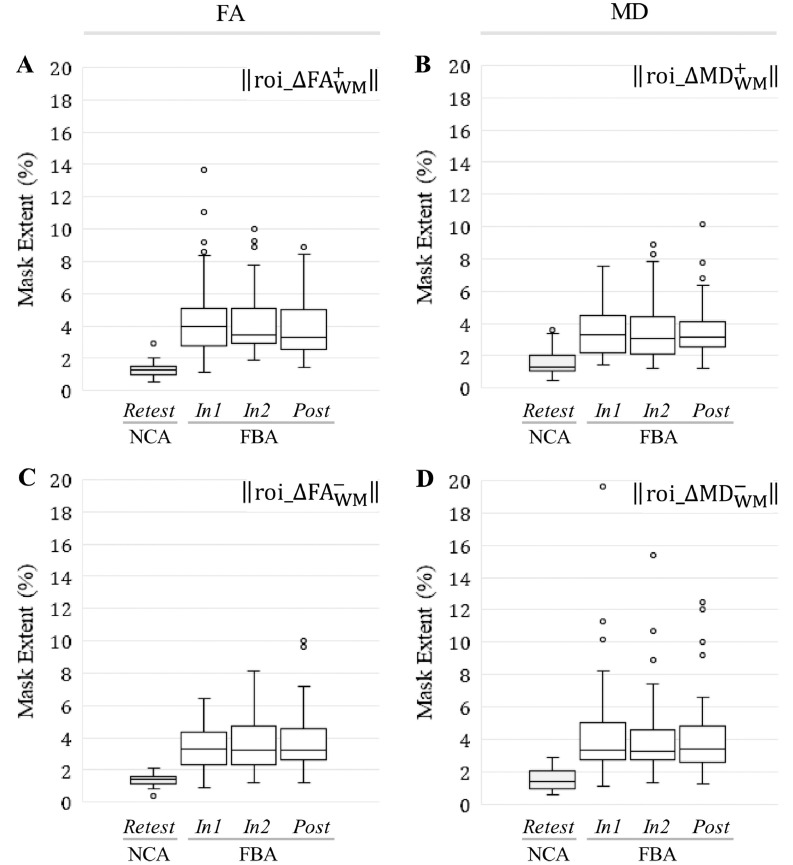
At all follow-up sessions, football athletes (FBA) exhibited significantly (p < 0.001) greater spatial extents of substantial increase/decrease in FA and MD, within ROIWM, than did noncollision athletes (NCA). Box-and-whisker plots are presented at each follow-up session for (A) ‖roi_ΔFAWM,j,i+‖; (B) ‖roi_ΔMDWM,j,i+‖; (C) ‖roi_ΔFAWM,j,i−‖; (D) ‖roi_ΔMDWM,j,i−‖.